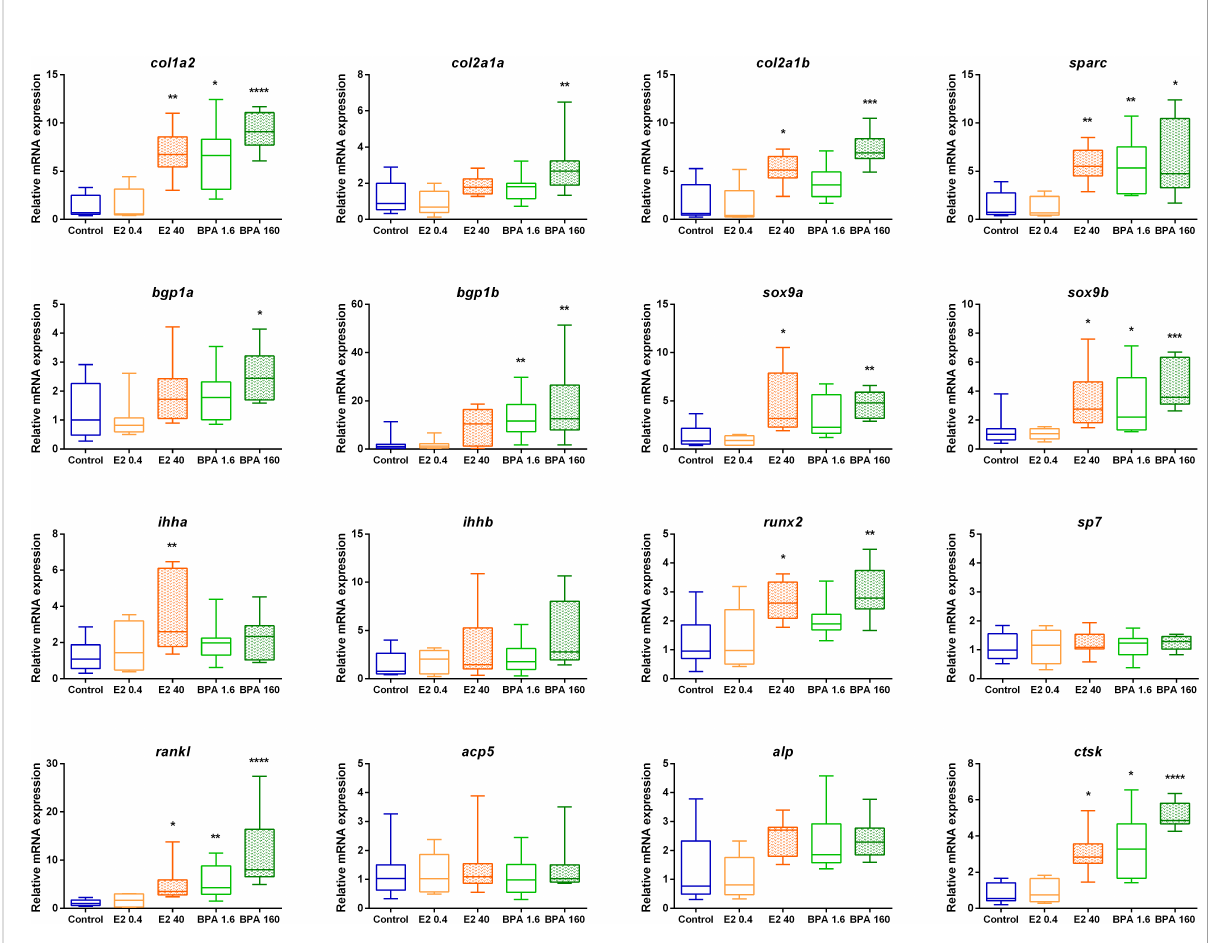
FIGURE 4 Relative mRNA expression of mineralization-related genes in 16-dph individuals exposed for 4 days at nominal concentrations of E2 0.4 and 40 ng.L -1 , BPA 1.6 and 160 m g.L -1 , and ethanol 0.0008% (v/v) as a solvent control. Relative mRNA levels are expressed as DD Cp with solvent control as a reference (n=8-10 individuals). In boxplots, hinges indicate fi rst and third quartiles; whiskers indicate the min and max values, and horizontal lines indicate the median. Difference between treatments was tested using the non-parametric multiple comparison test Kruskal-Wallis, followed by Dunn ’ s post-hoc test. Black stars indicate signi fi cant differences compared to the solvent control (multiplicity adjusted p-value: *p < 0.05; **p < 0.01, ***p < 0.001, ****p <